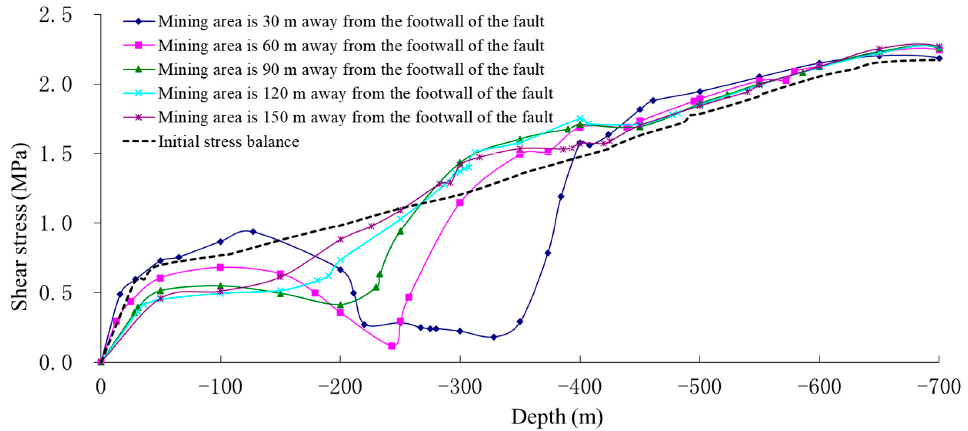
Figure 8. When the mining area is situated within the fault footwall, the shear stress distribution on the fault plane is at various locations.